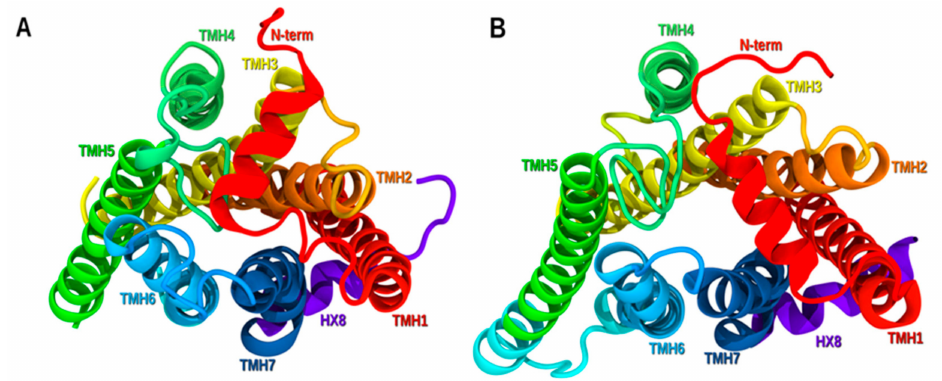
Figure 3. A comparison of ( A ) the S1P1 inactive state crystal structure and ( B ) the GPR6 inactive state model. The view here is from the extracellular side of each bundle.